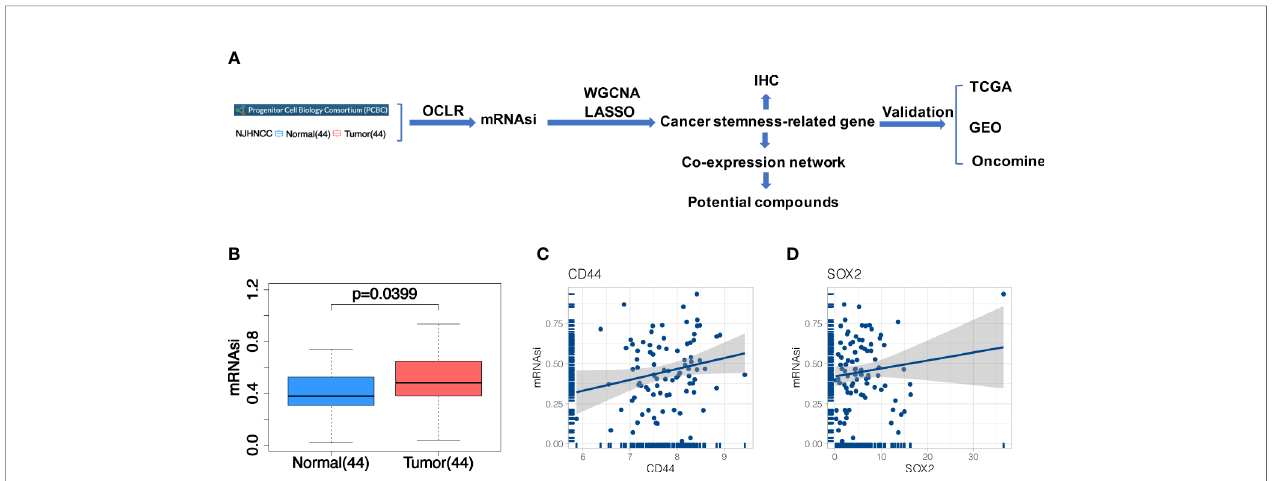
FIGURE 1 | (A) The fl owchart of the study; (B) Differences of mRNAsi between 44 tumor and 44 matched normal samples from NJHNCC. Line in the box indicates the median and boxes correspond with the fi rst and third quartiles; (C, D) Correlation analysis between mRNAsi and HNSCC stemness marker (CD44, SOX2). It indicated the good fi tness of mRNAsi with HNSCC